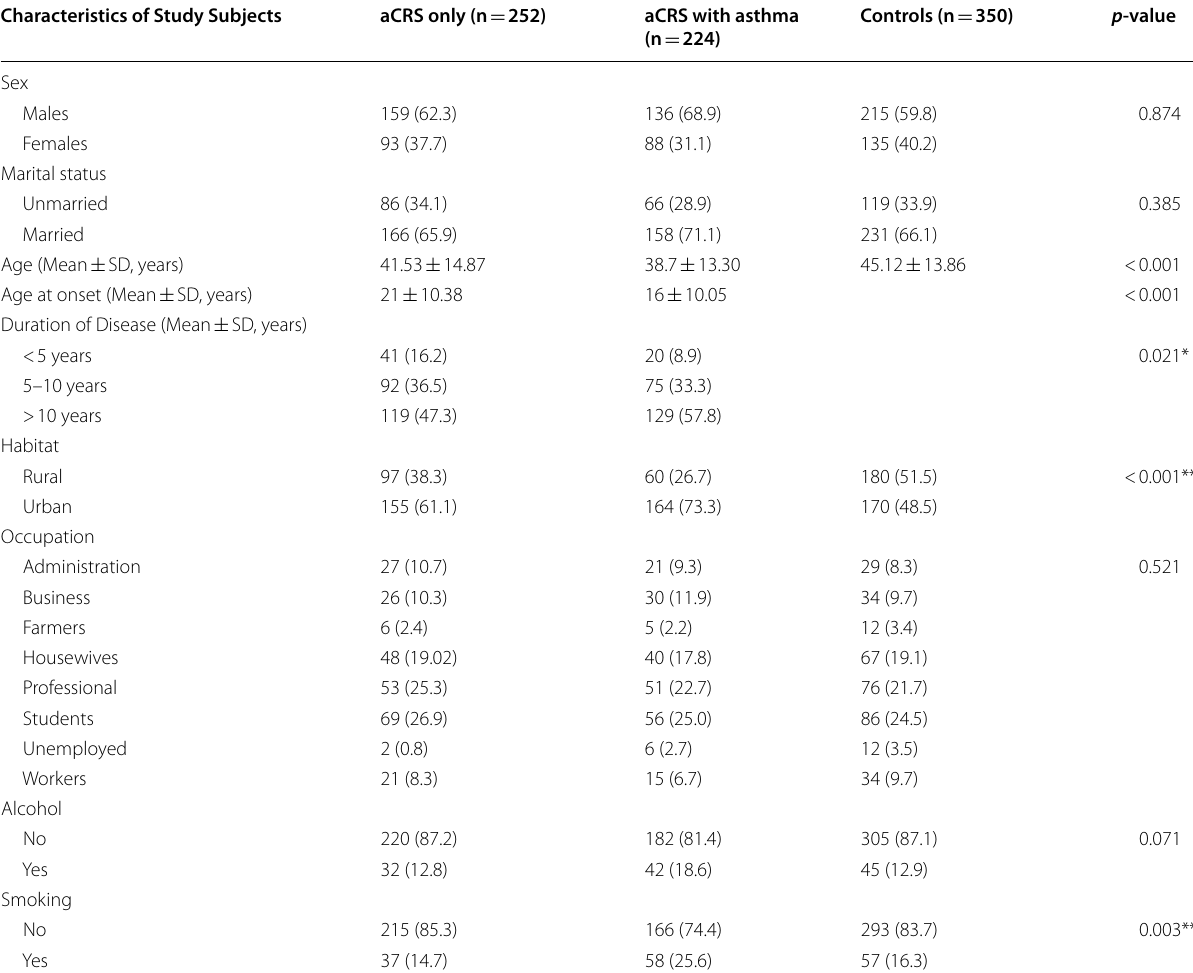
Table 2 Demographic of subjects with allergic CRS, allergic CRS with asthma and controls